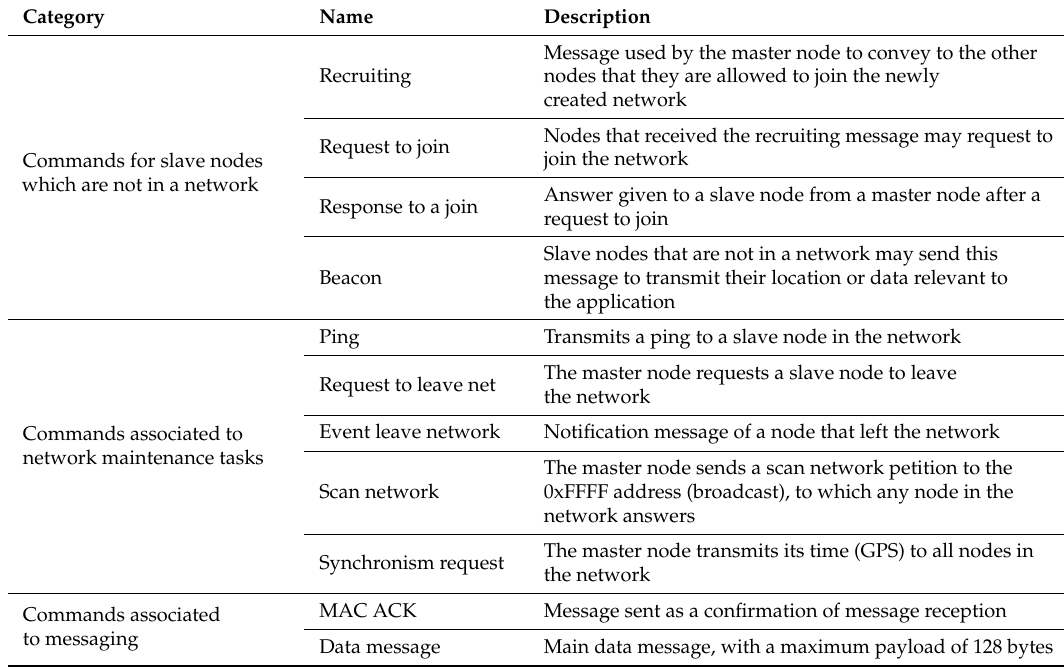
Table 1. Network device commands implemented in LoRaNET.